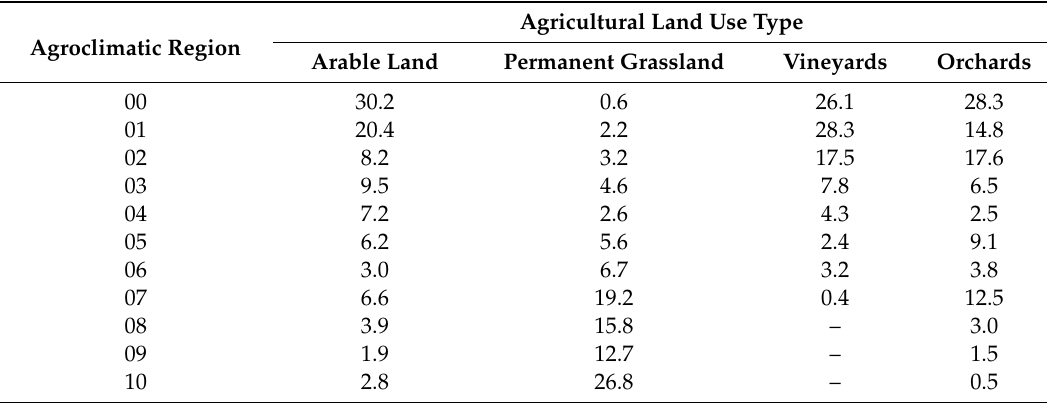
Table 3. Share of agroclimatic regions (%) in agricultural land use types in Slovakia. Agricultural Land Use Type Agroclimatic Region Arable Land Permanent Grassland Vineyards